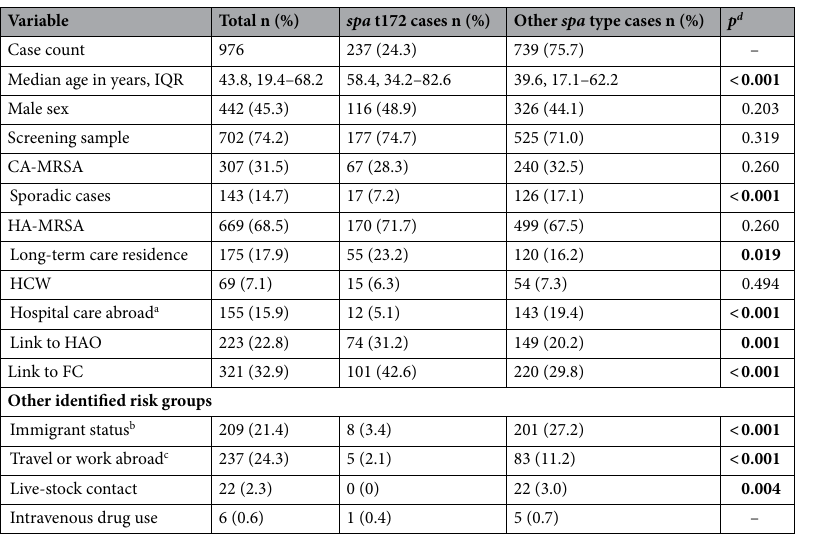
Table 1. Demographic and epidemiological characteristics of t172 and other spa type MRSA cases, Hospital District of Southwest Finland, years 2007–2016. a Within previous two years b Asylum seeker, refugee, resident of other country or other immigrant c Within the previous year d Fisher exact test or Mann–Whitney U test where appropriate d Statistical significance p < 0.05. IQR Interquartile range, HCW Healthcare worker, CA/ HA-MRSA Community-associated/Healthcare-associated Methicillin resistant S. aureus , FC Family cluster, HAO Healthcare-associated outbreak. Significant values are in